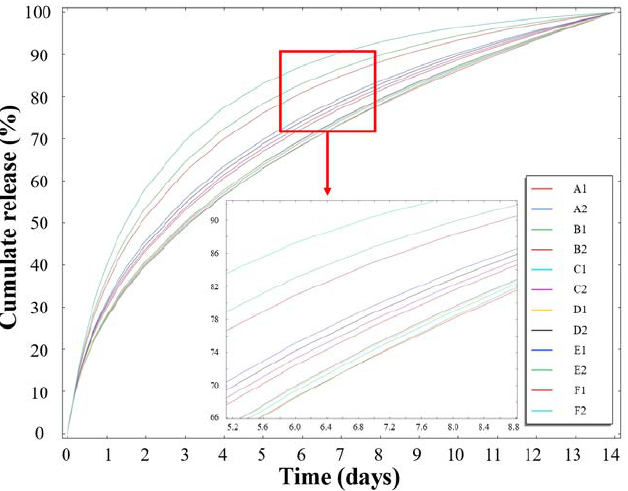
Figure 9. Simulation of imiquimod release under different drug loadings and mesh diameters (see Table 2 for sample identification).